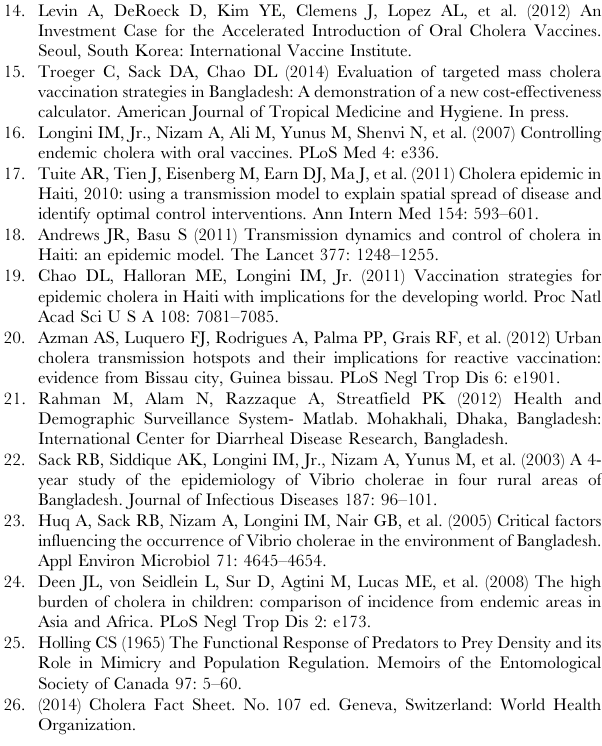
Text S2 1. Table S1. Parameters and ranges used in the main analysis. 2. Table S2. Transmission rates and relative suscepti- bility by age used in the model. 3. Table S3. Magnitude and duration of the periods of elevated environmental risk. 4. Figure S1. Direct vs. indirect transmission. 5. Figure S2. Projected variation in the proportion of individuals recovered from cholera by age group assuming no vaccination. 6. Figure S3. Overall effectiveness of mass vaccinations over 1 year for vaccine with 5 year of average protection assuming that: 7. Figure S4. Modeling 5-year campaign and continuous vaccination strategies for vaccine with 5 years of average protection assuming uniform efficacy (65%) for all age groups. 8. Figure S5. Modeling 3-year campaign and continuous vaccination strategies for vaccine with 3 years of average protection assuming uniform efficacy (65%) for all age groups. 9. Figure S6. Model dynamics assuming 25% of cholera cases are reported. 10. Figure S7. The effectiveness of different vaccination strategies for vaccine with 5 years of average protection assuming that 25% of cholera cases are reported. 11. Figure S8. Model dynamics assuming the duration of protection after cholera infection varies across age groups. 12. Figure S9. Effectiveness of different vaccination strategies for vaccine with 5 years of average protection assuming different duration of natural immunity across age